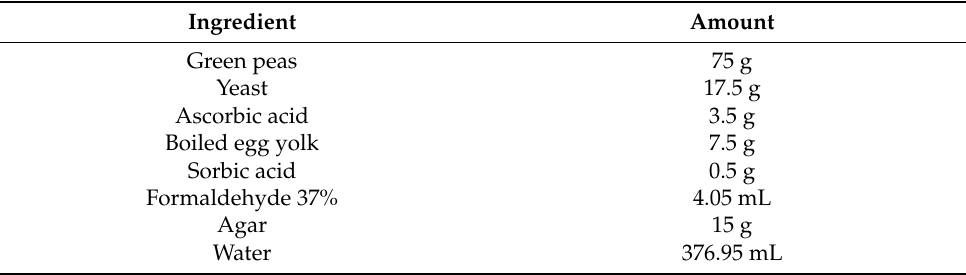
Table 8. Composition of artificial diet used in dose–response experiment with Chilesia rudis